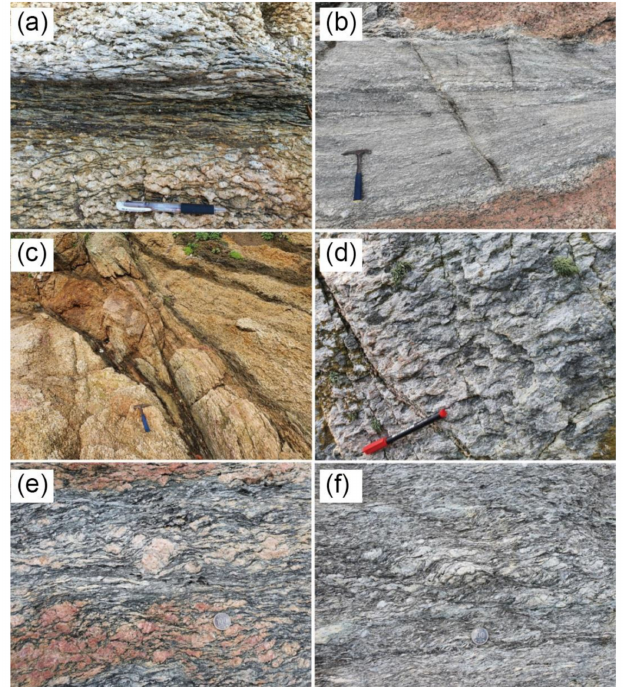
Figure 2. Outcrop photographs of the alkali feldspar granite (AFG). ( a , b ) Discrete shear zones, mainly composed of ultralmylonite. ( c ) Anastomosing shear zones surrounding lenses of weakly deformed AFG. ( d ) Gently plunging lineation on mylonitic foliation plane. ( e , f ) Kinematic indicators with a dextral sense of shear, including shear bends, σ -type alkali feldspar porphyroclasts, and S/C–composite fabrics.